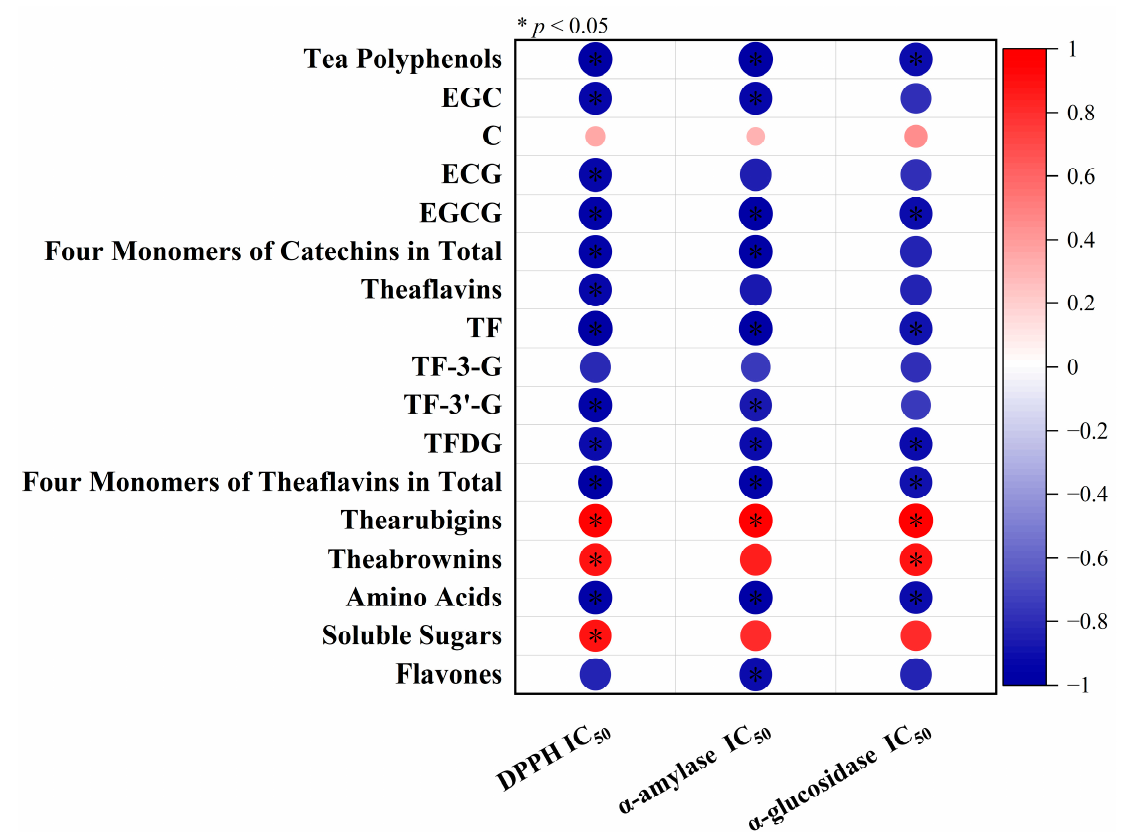
Figure 6. Correlation analysis of IC 50 values of DPPH, α -amylase and α -glucosidase with taste component contents, with red for positive correlation and blue for negative correlation; darker color and larger circle area indicate a larger correlation coefficient; * indicates significant difference at p < 0.05.